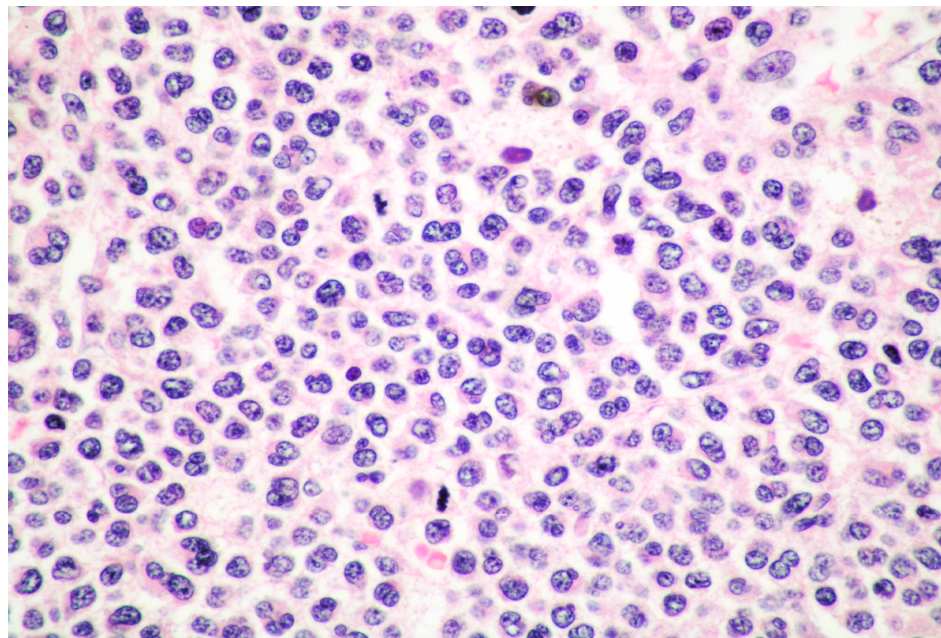
Figure 1. High power view of BM biopsy diffusely infiltrated by promastocytes (hematoxylin and eosin, magnification 300×; original image from Prof. S.A.).